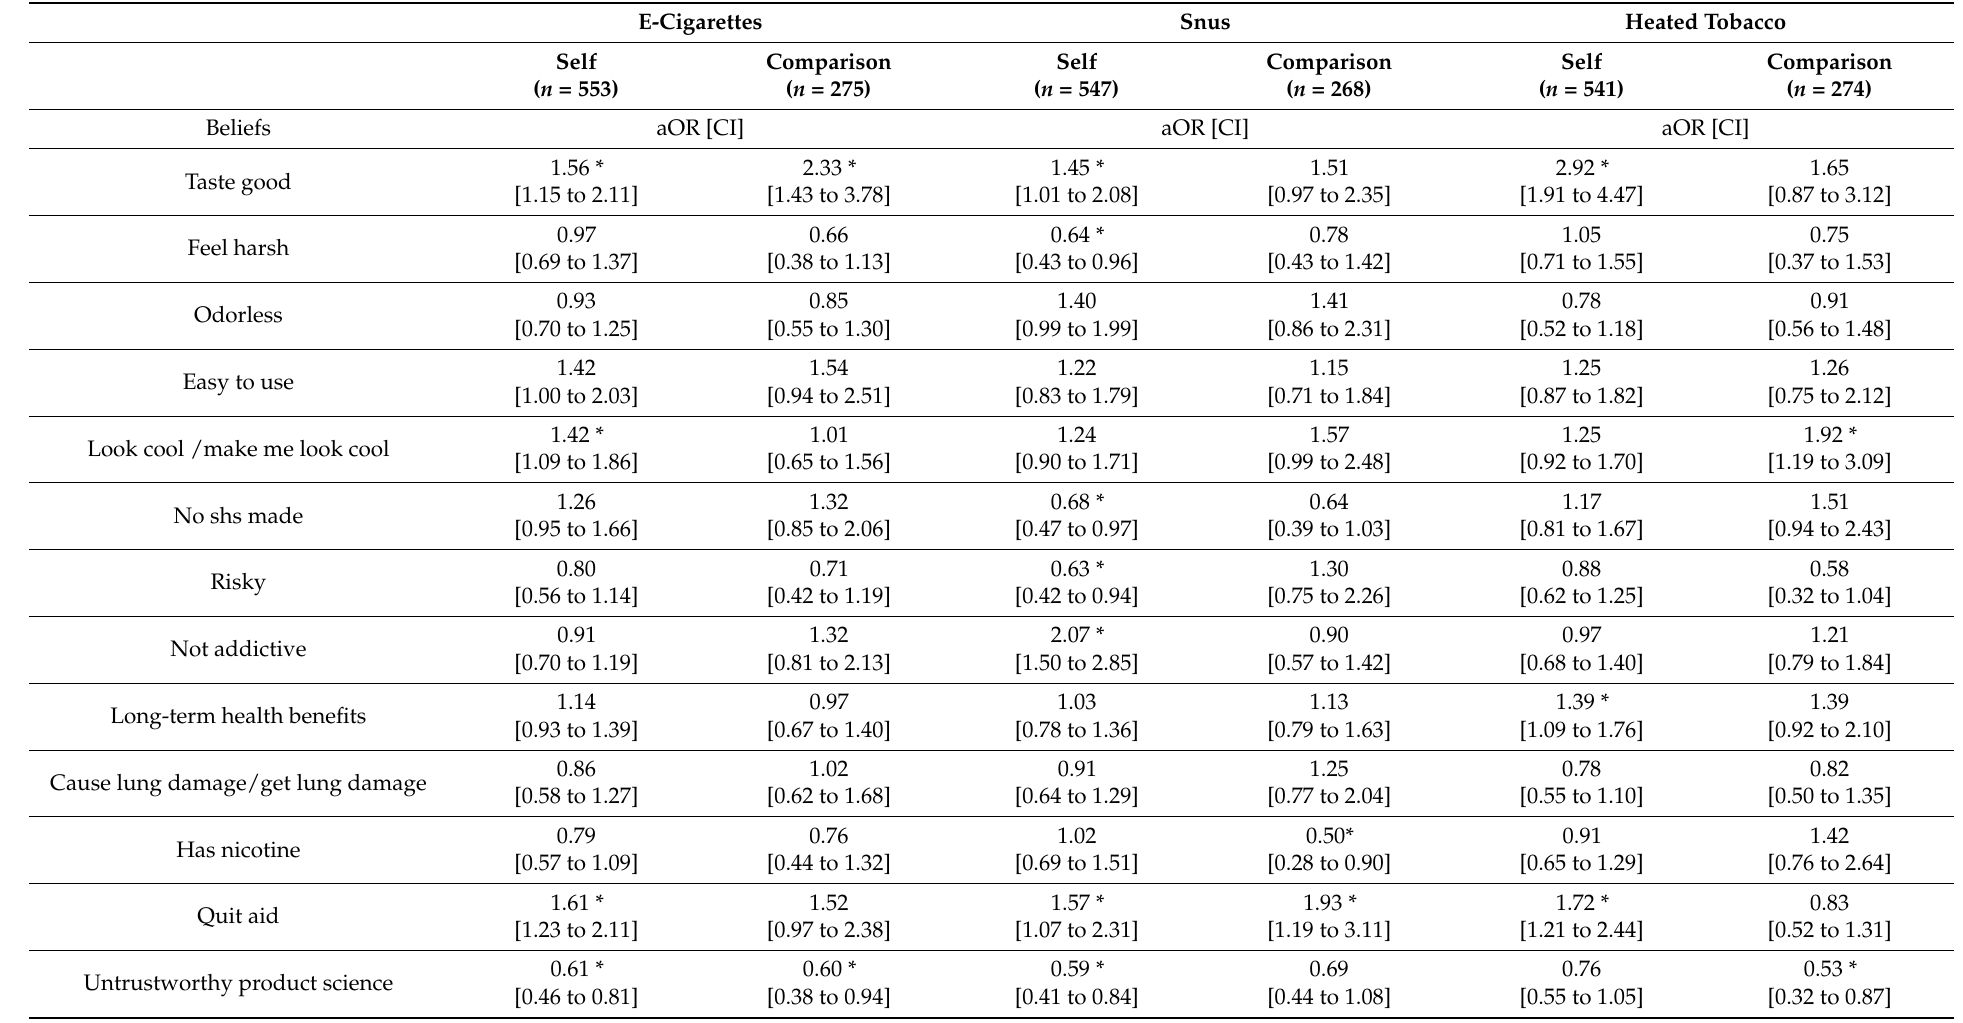
Table 6. Multiple logistic regression adjusted odds ratio of any intention to use e-cigarettes, snus, or heated tobacco, n =